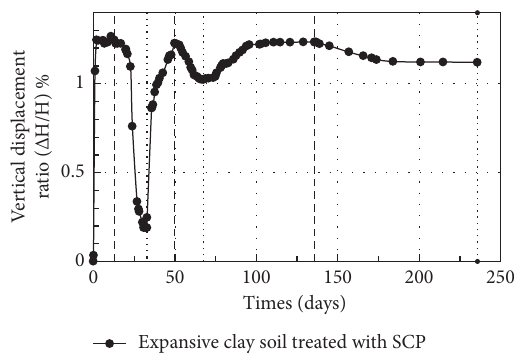
Figure 9: Vertical displacement ratio versus time for TECS.